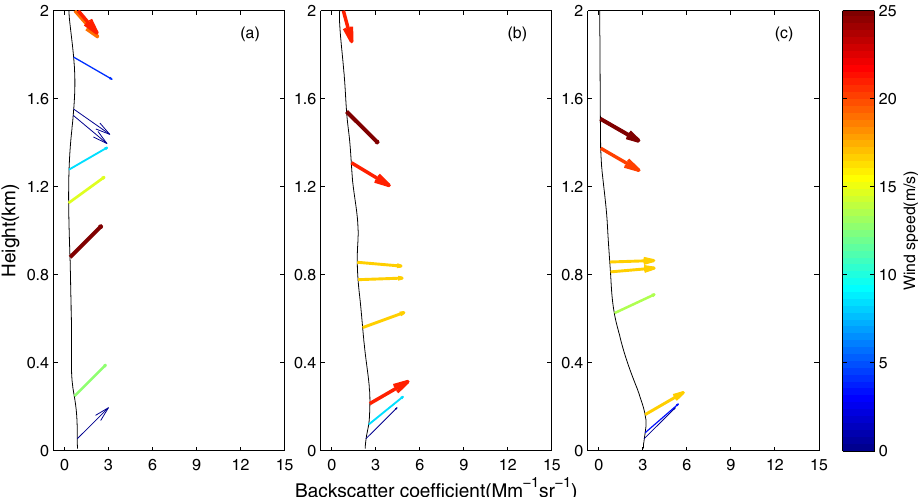
Figure 12. Attenuated backscattering coefficients and wind vectors for 6–11 November at (a) 20:00LT on 7 November, (b) 20:00LT on 8 November, and (c) 20:00LT on 10